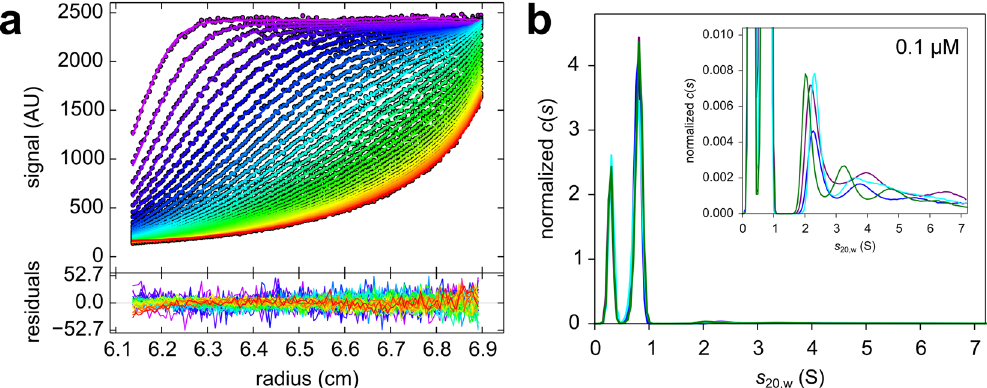
Figure 1. SV analysis of 0.1 µ M AF488-A β 42 with fluorescence detection reveals the existence of small oligomers in addition to the monomer. ( a ) Raw data of SV experiment with overlaid lines for the fitted data, showing a signal intensity of about 2500 RFU. Only every third scan, as well as every third data point is shown for clarity. In the box below the corresponding residuals within the fitted data range are shown. Rmsd for this sample was 11.86. ( b ) Area normalized c ( s ) results for four independent samples of 0.1 µ M AF488-A β 42 have been superimposed in the graph. The 0.8 S species is assigned to the monomer, the peak at 0.3 S is the result of either incomplete removal of unincorporated dye or the dark count rate or a combination of both. The inset shows the magnification of c ( s ) distributions. Sedimentation was performed at 60,000 rpm, 20 °C.